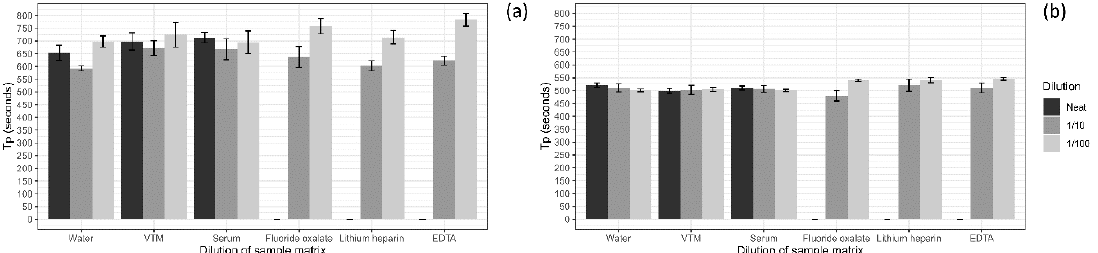
Figure 3. The effect of sample matrix on the detection of a low (400 copies/rxn) ASFV gBlock spike ( a ) and a medium (40,000 copies/rxn) ASFV gBlock spike ( b ), with the sample matrix tested at neat (black), 1 in 10 (dark grey) and 1 in 100 (light grey) dilution in nuclease-free water. All runs were performed in triplicates. No signal was detected for the ASFV gBlock when spiked into neat